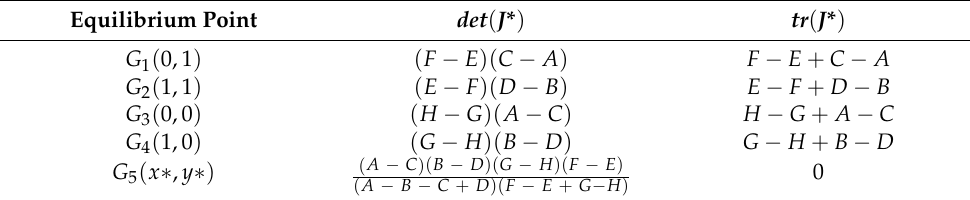
Table 4. Equilibrium point analysis.